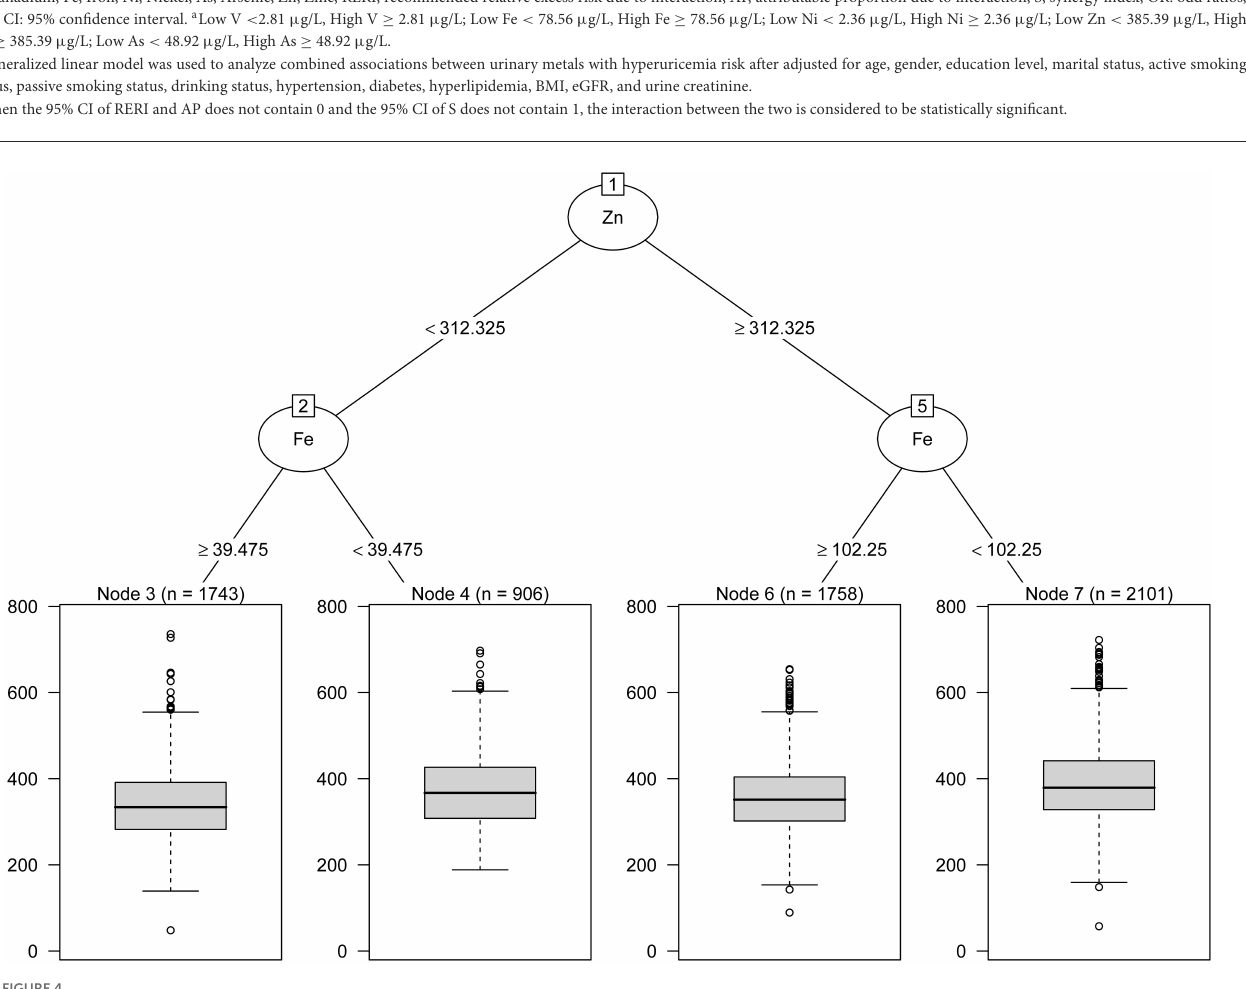
detected urinary metal concentrations, which is a limitation in assessing metal exposure of the body, because day-to-day variability of urinary metals concentrations and creatinine excretion of the body can result in measurement errors. But, it cannot deny the role of urinary sample, because of the high amount of metal excretion